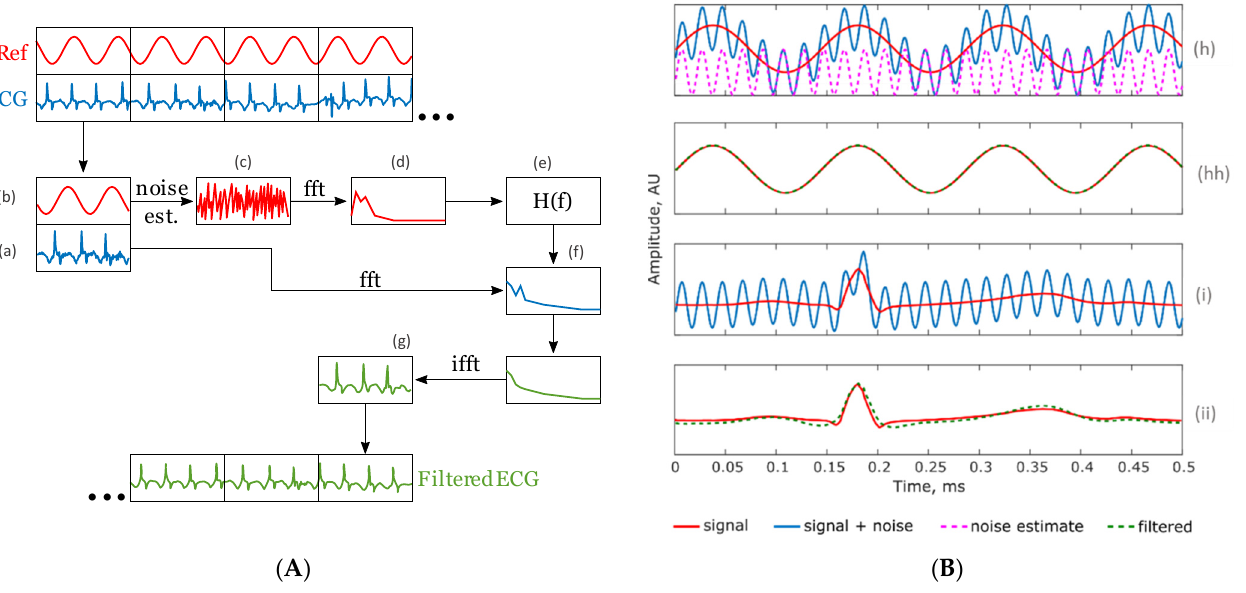
Figure 2. Details of the proposed bio-signal denoising approach. ( A ) Functional blocks and applica- tion of the Wiener filter. ( B ) Two example signals after applying the proposed denoising approach: (h) reference sine signal and noise replica (dotted line); (hh) reference sine signal after filtering; (i) idealized ECG signal highlighting QRS complex measured at the sensor’s output; (ii) ECG signal after filtering.